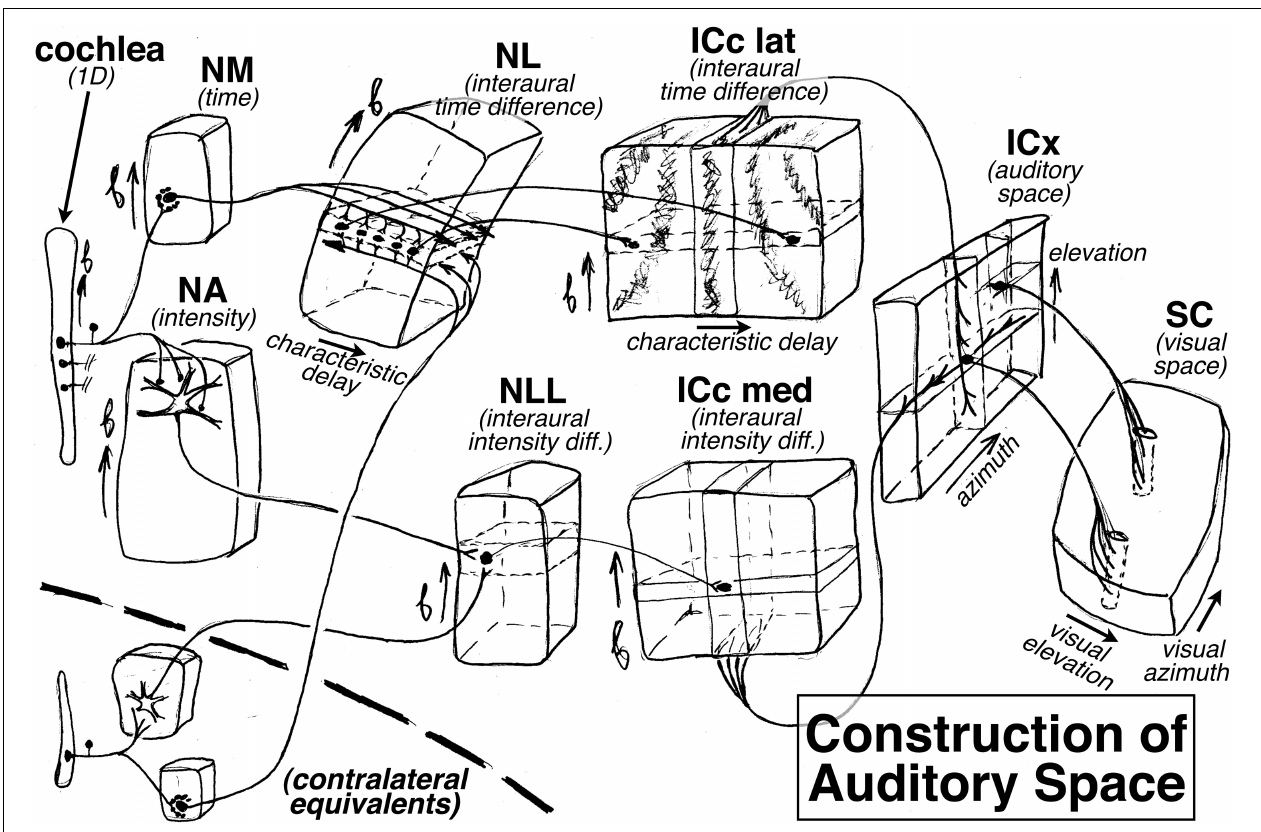
FIGURE 4 | How the auditory system plays with maps: construction of an auditory space map from two ( left and right ) frequency maps in the barn owl. The ‘extra’ dimension perpendicular to tonotopy is used to construct maps of other features, such as characteristic delay in the nucleus laminaris (NL) and the inferior colliculus central nucleus lateral part (ICc lat), and eventually an auditory map of space in the external nucleus of the inferior colliculus (ICx), which is finally sent to the superior colliculus